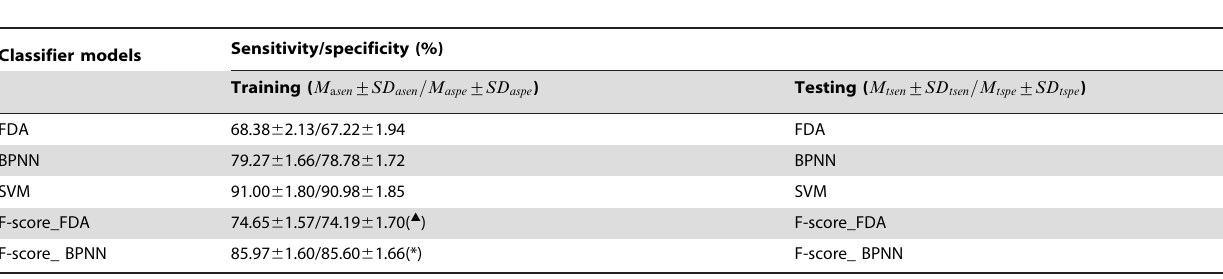
Table 3. Sensitivity/specificity on the training and testing sets for different classification models with the optimal parameter